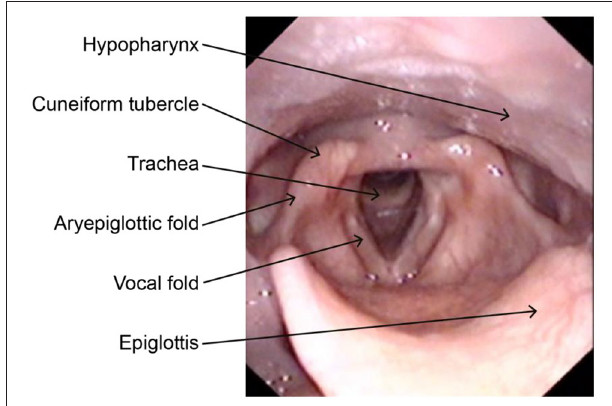
FIGURE 1 | Laryngeal anatomy with relevant landmarks as seen through a